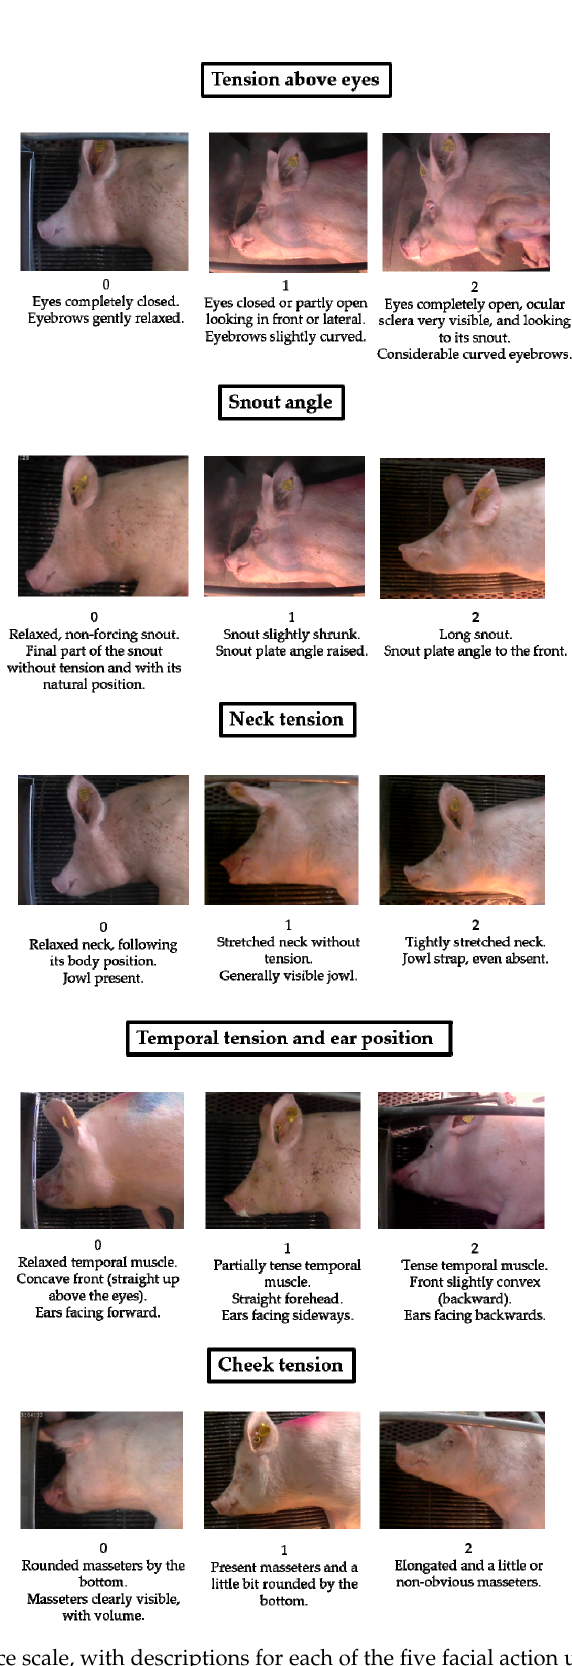
Figure 1. Sow grimace scale, with descriptions for each of the five facial action units (FAUs) employed: Tension above eyes, Snout angle, Neck tension, Temporal tension and ear position, and Cheek tension. FAUs are scored based on a three-grade scale: (score 0 = painless; score 1 = moderate pain and score 2 = severe pain).